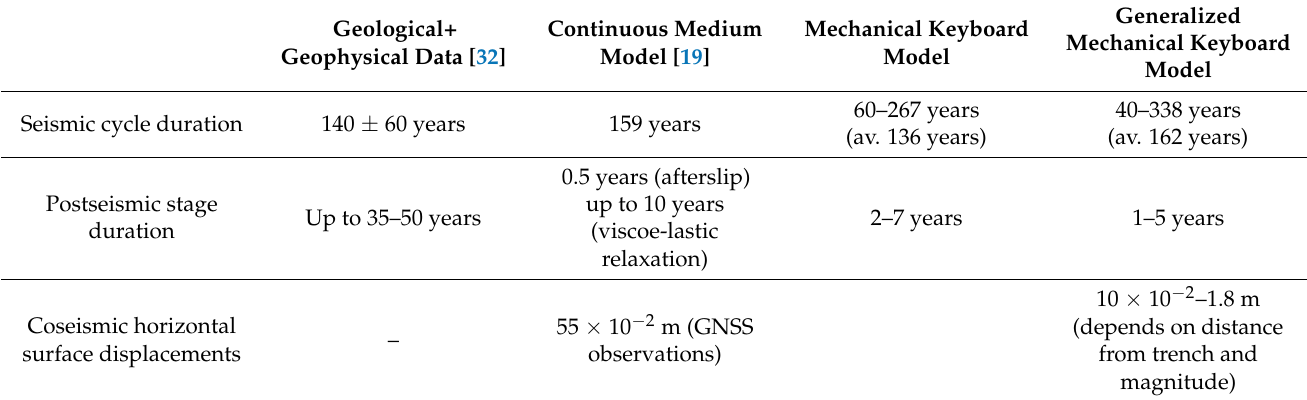
Figure 11. Model of the mechanical coupling distribution in the source zone of the 2006 Simushir earthquake. Black arrow displays magnitude and direction of the plate convergence vector [41]. Table 3. Main characteristics of the seismic deformation cycle in the Kuril-Kamchatka subduction